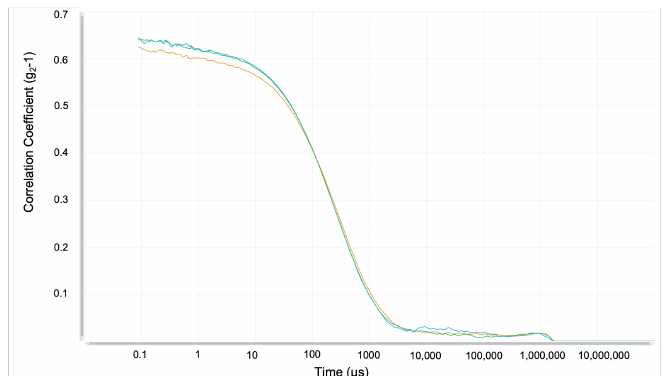
Figure 5. Illustrative example displaying three curves (blue, green, and orange) obtained from DLS experiments, each of them representing the correlation function ( ( g 2 − 1) vs. t ) of an independent measurement of the same sample. Additional experimental data typically measured from the correlation function are the z-average size of 190 nm ± 8.3 nm, a PDI of 0.56, derived mean count rate 366 ± 15.7 kpcs, and a diffusion coefficient of 2.60 ± 0.111 µ m 2